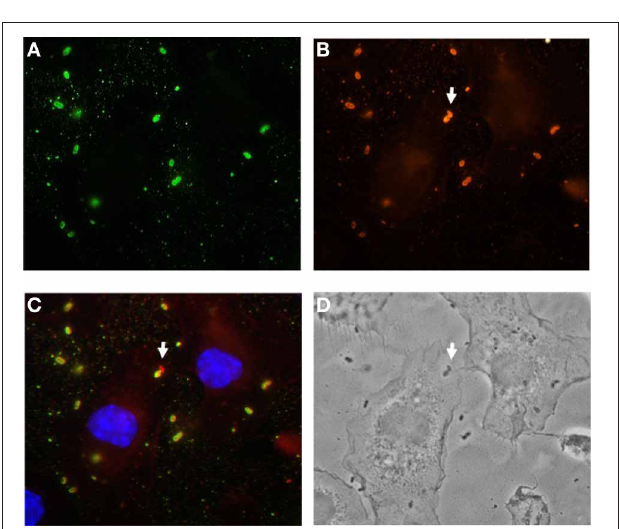
FIGURE 7 | Poor uptake of S. pneumoniae by bone marrow-derived DCs in in vitro assays. Bone marrow-derived DCs were infected with S. pneumoniae for 2h, fixed, and stained for with polyclonal rabbit anti- S. pneumoniae antibodies, followed by Alexa green-conjugated goat anti-rabbit antibodies (A) . Cells were then permeabilized with 0.025% Triton X-100 in PBS, and intracellular bacteria were stained by anti- S. pneumoniae antibodies, followed by Alexa red-conjugated goat anti-rabbit antibodies (B) . In the merged image shown in (C) , extracellular bacteria are yellow-green, intracellular bacteria are red and the DNA in the nucleus of DCs is stained in blue. The white arrow indicated an intracellular S. pneumoniae . (D) Phase contrast picture showing the contour of the